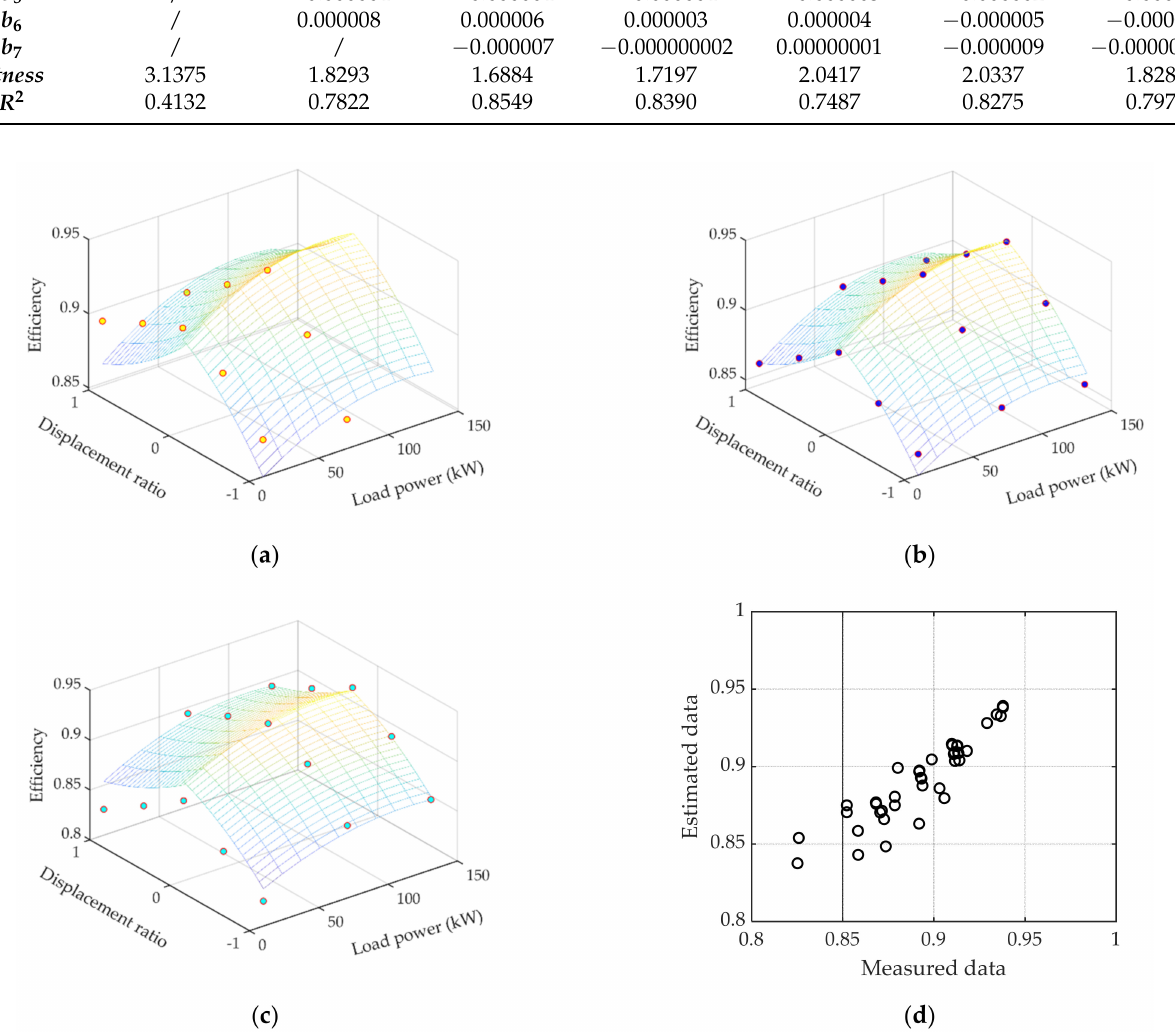
Figure 9. The comparison between estimated values and measured values. ( a ) Engine speed